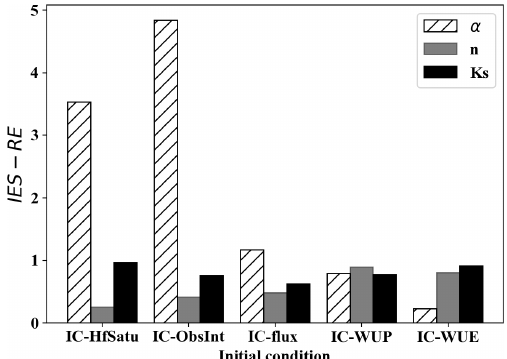
Figure 9. The RE results of parameter estimations under five initial- ization methods with IES when the simulation time is 60d (Case